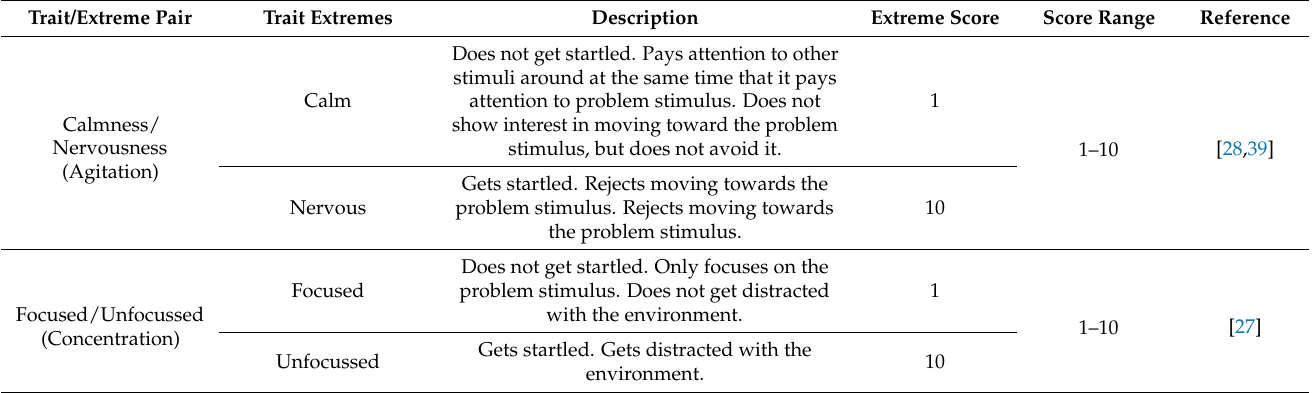
Table 1. Summary of personality trait descriptors used in the testing stage of the judgement bias test, score ranges/scales, trait extremes and the references from which these were